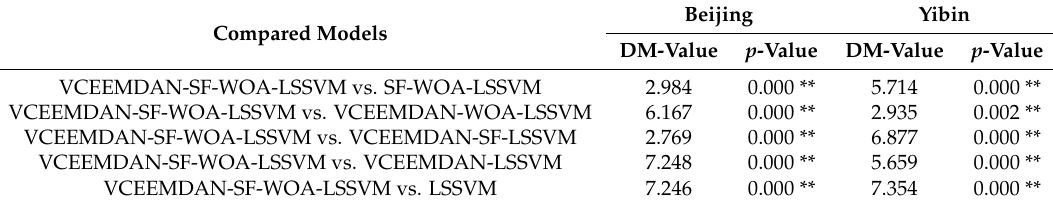
Table 5. Results of DM test for Experiment